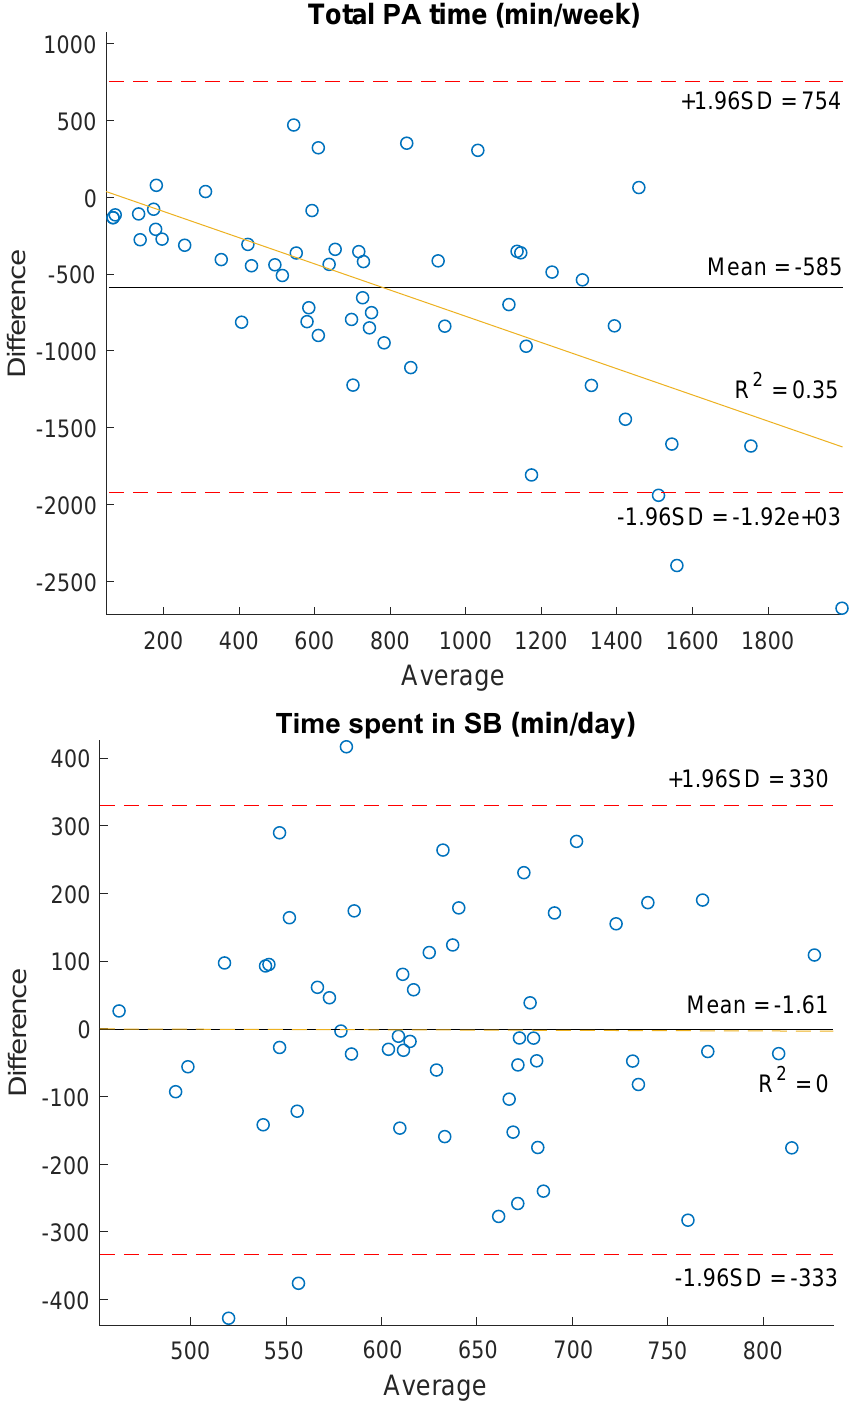
Figure 2. Bland-Altman plots showing the difference vs average between the IPAQ-LF and accelerom- etry in: ( a ) time spent in moderate-to-vigorous intensity physical activity; ( b ) total physical activity time; ( c ) time spent in sedentary behavior. Solid black lines represent the mean of the differences, dotted red lines indicate the 95% limits of agreement and solid yellow lines represents the linear regression